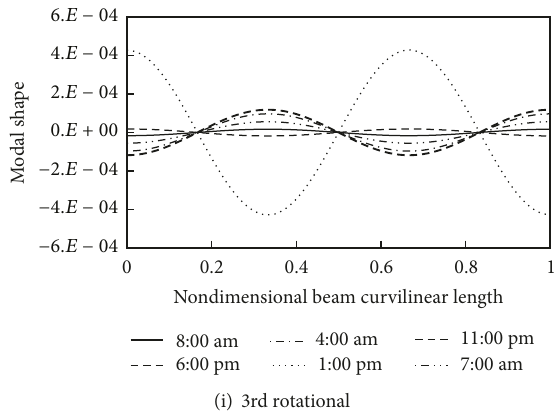
Figure 16: The modal shapes at different times.